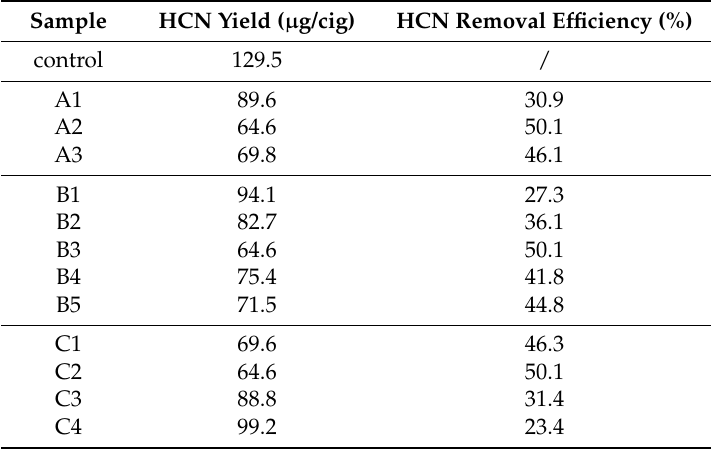
Table 2. The HCN removal efficiency of CMC/CA